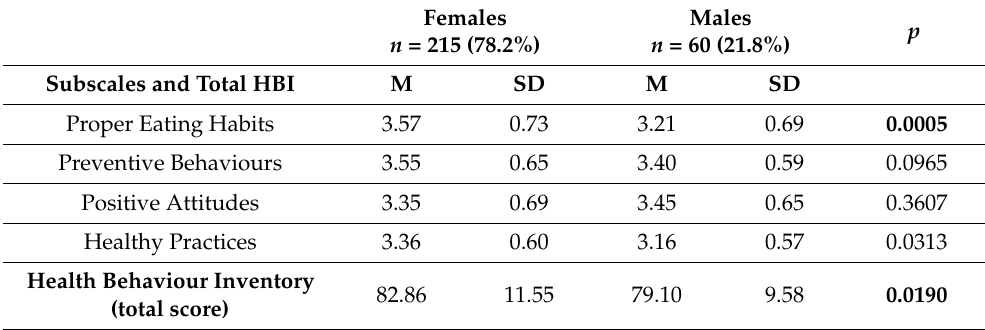
Table 4. Sex vs. health